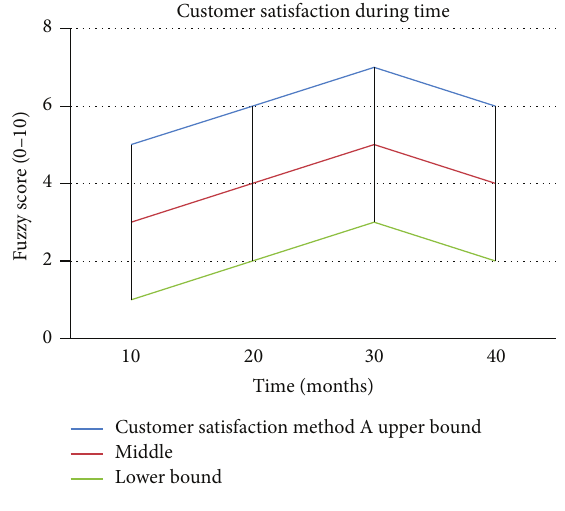
Figure 1: Fuzzy time